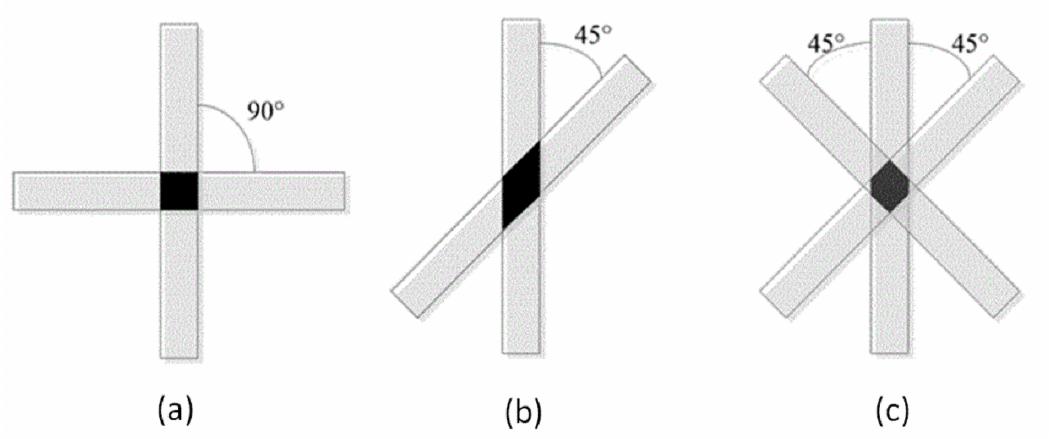
Figure 17. Contact area of adjacent layers with di ff erent internal structures. ( a ) 0 / 90 degree internal structure; ( b ) 0 / 45 degree internal structure; ( c ) 0 / 45 / 135 degree internal